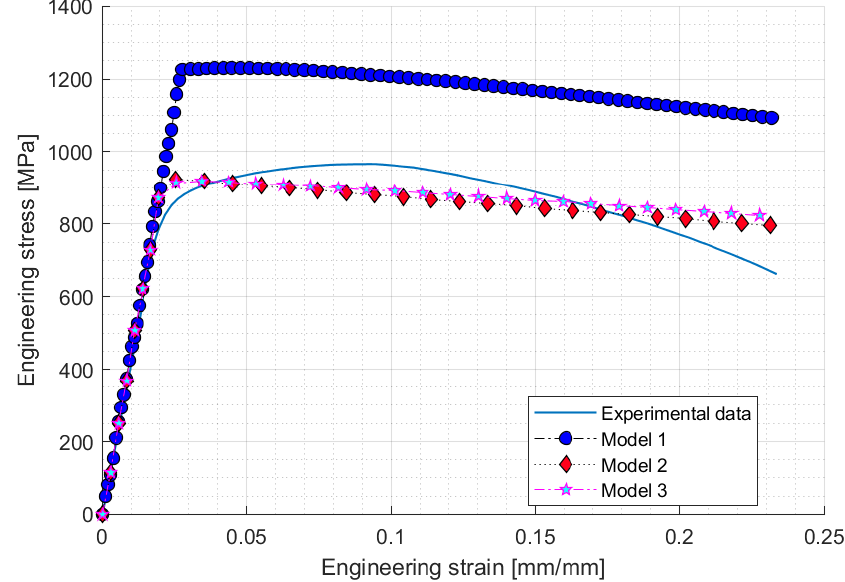
Figure 12. Inverse method results for typical method.